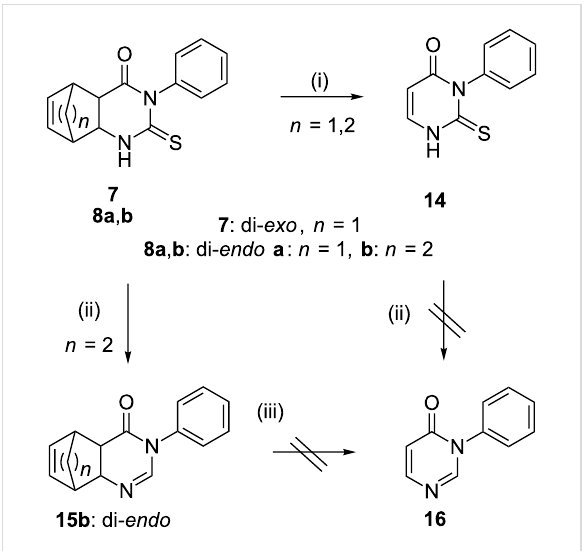
Scheme 2: Synthesis of tricyclic ethanoquinazolin-4( 3H )-one 15b ; (i) MeCN, F R = 0.5 mL min − 1 , 220–250 °C; (ii) EtOH/H 2 O =